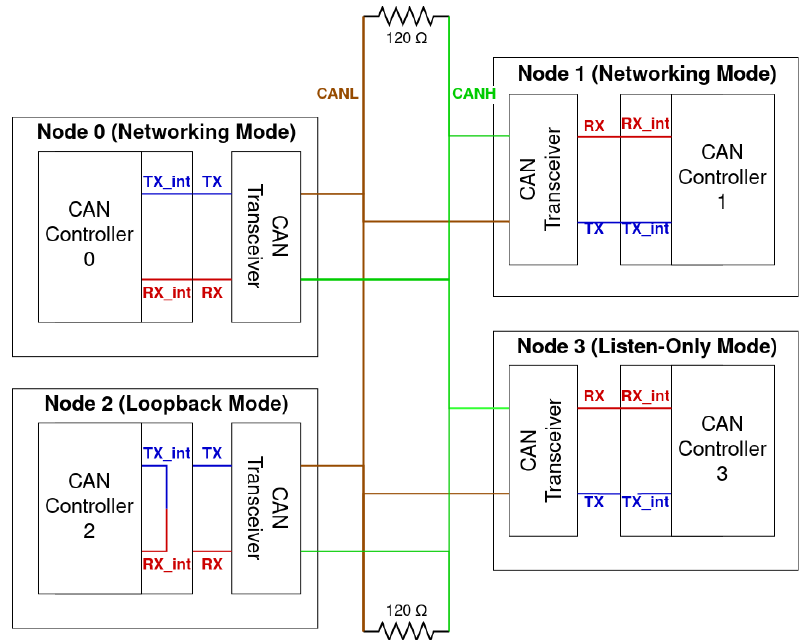
Figure 3. Bus configuration with every test